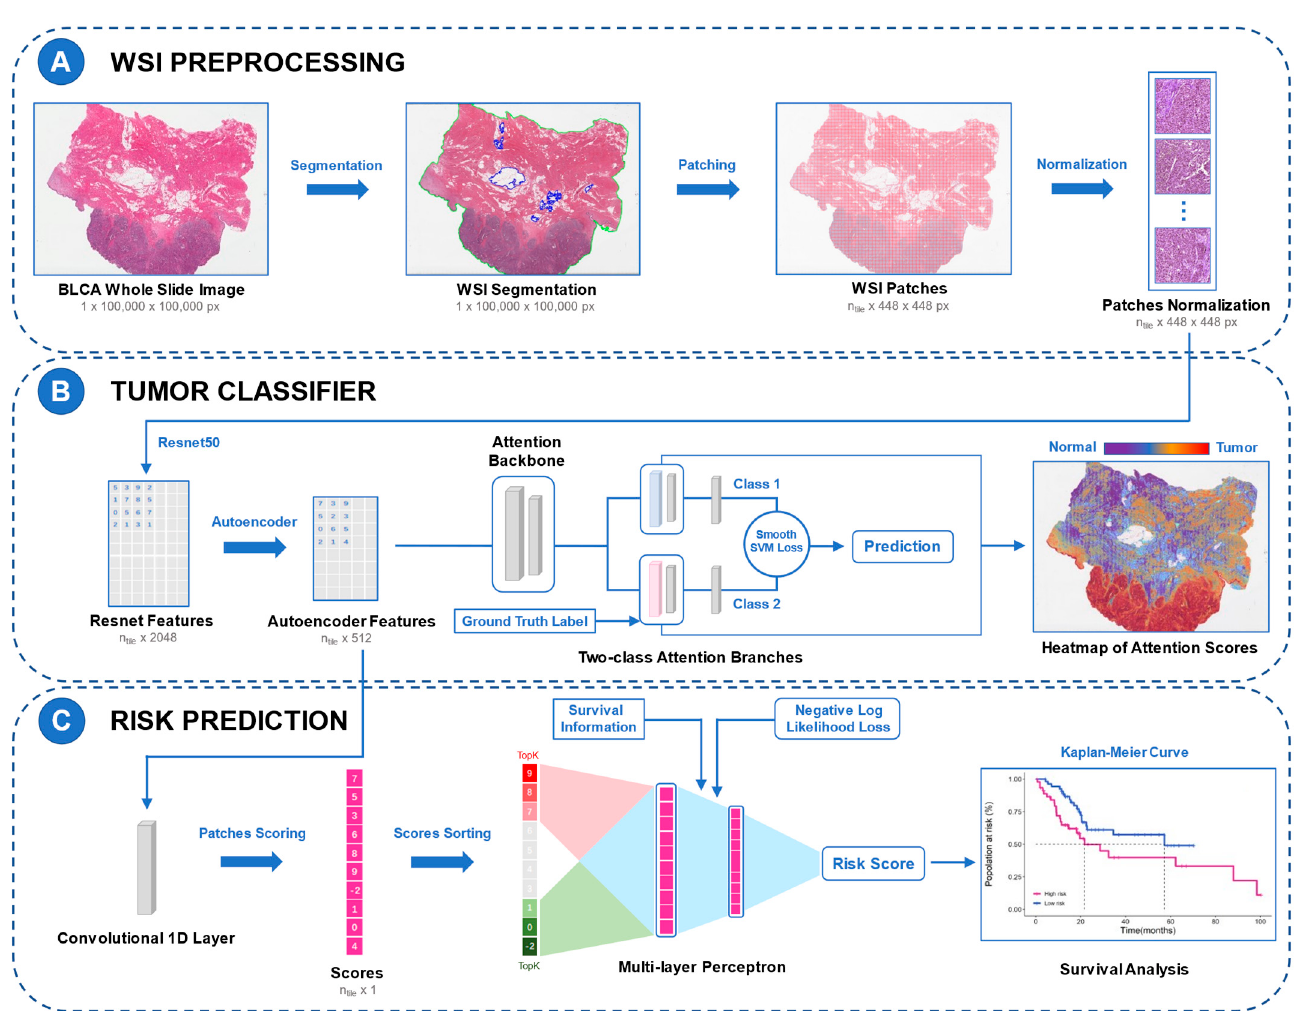
Figure 1. Study flow chart and the layouts of the DL models. The framework of BlcaMIL is shown in A and B and the framework of MibcMLP is shown in A and C. ( A ) Each WSI was first segmented into tissue-containing regions (green border) and empty regions inside the tissue (blue border), and then patches with 448 × 448 pixels were generated. ( B ) Feature extraction was performed on all patches using ResNet-50, and dimensionality reduction was performed with Autoencoder. Through the MIL model with attention mechanism, the extracted patch-level features were input into the BlcaMIL model, the attention scores of these patches were output, and the average pooling function was used to aggregate them into the WSI-level to make the final diagnosis. Heatmaps visualize ROIs for the model. ( C ) Patch-level features were fed into the network along with survival information, and each patch was assigned a risk score through an iterative learning process. Then, the 50 patches with the highest and lowest scores were selected to be input to the MLP model to predict patient survival. Finally, MIBC patients were stratified using the resulting risk scores. DL, deep learning; WSI, whole slide image; MIL, multiple instance learning; ROI, region of interest; MLP, multi-layer perceptron; MIBC, muscle invasive bladder